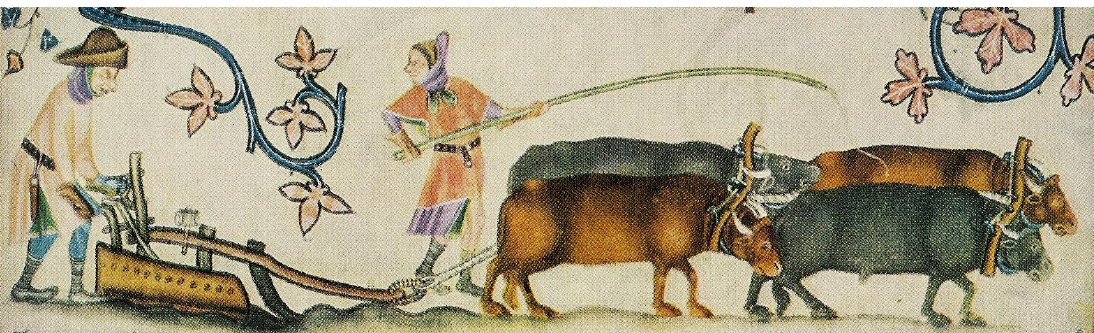
Figure 10. Ploughing with oxen, Luttrell Psalter, circa 1335–1340, detail (The British